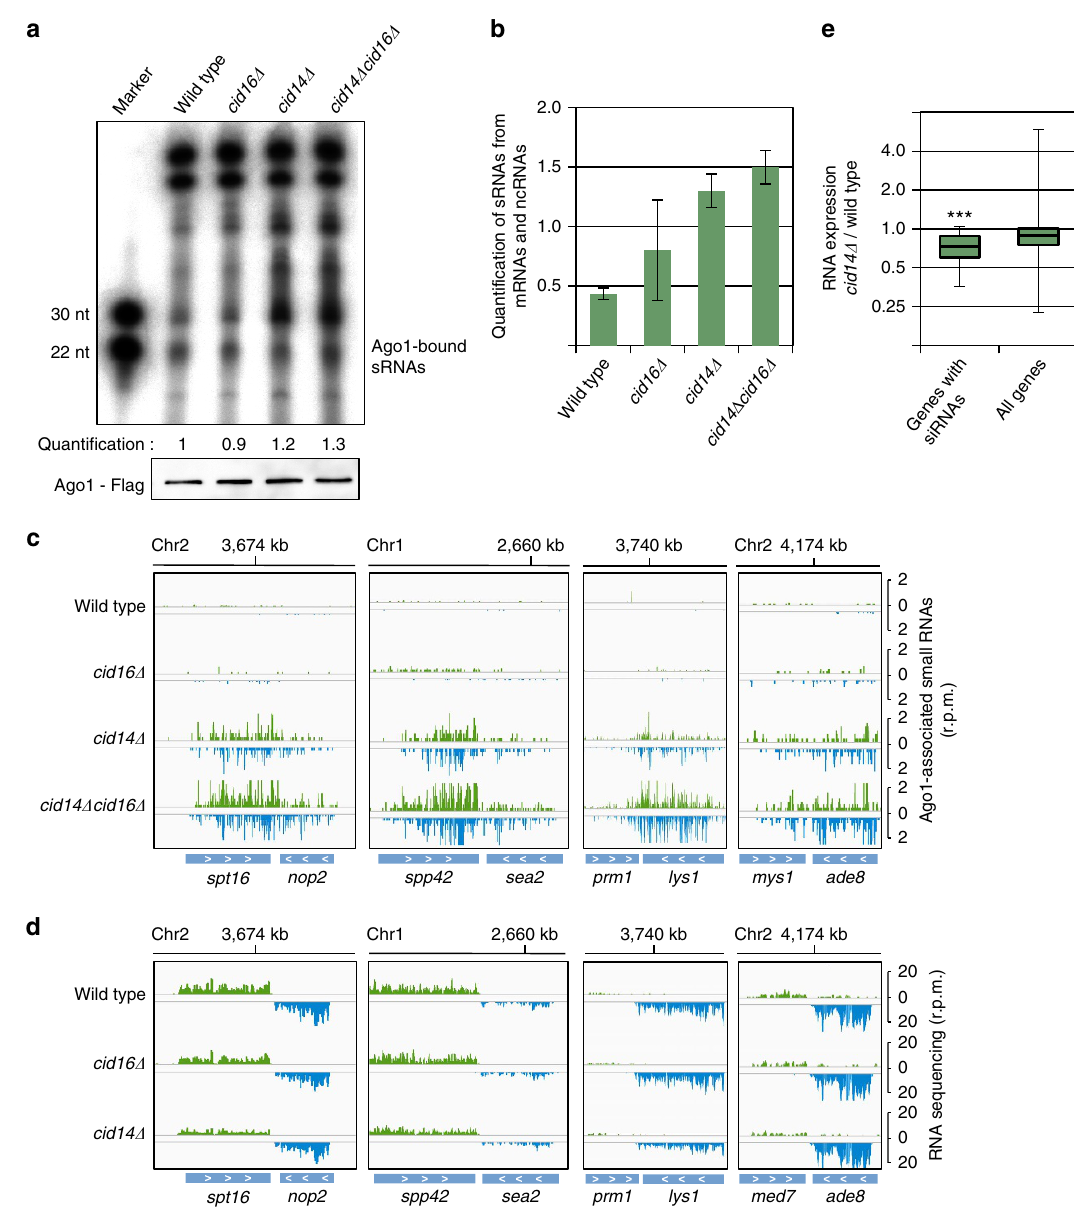
Figure 3 | Accumulation of antisense priRNAs triggers uncontrolled RNAi in cid14 D cells. ( a ) Autoradiograph of denaturing polyacrylamide gel showing Argonaute-bound RNAs purified from wild type, cid16 D , cid14 D and cid14cid16 D cells. Quantification is based on two independent biological replicates. Each band was normalized to higher unspecific bands of its lane and compared to wild type. Lower panels show western blotting detection of Flag-Argonaute protein in immunoprecipitation assays. ( b ) Quantification of euchromatic Argonaute-bound siRNAs and priRNAs mapping to mRNAs and ncRNAs in indicated strains. Euchromatic siRNAs and priRNAs accumulate in cid16 D , cid14 D and cid14cid16 D cells. Error bars indicate s.e.m. of two independent sRNA-sequencing experiments. ( c ) Argonaute-bound sRNA reads from indicated strains were plotted over euchromatic genes. The location of genes is indicated below the sRNA peaks. Reads from þ and (cid:2) strands are depicted in green and blue, respectively. Scale bars on the right denote sRNA reads numbers normalized per one million reads. In cid14 D and cid14 D cid16 D cells, RNAi targets euchromatic genes. ( d ) RNA-sequencing reads in indicated cells are plotted over the several euchromatic genes. In cid14 D cells genes that are targeted by RNAi are silenced. Scale bars on the right denote RNA reads numbers normalized per one million reads. ( e ) Box plot of differential expression of RNA in cid14 D cells compared to wild-type cells for all genes and genes that generate siRNAs in cid14 D cells. Genes that generate siRNAs show reduced level of mRNA in cid14 D cells indicating silencing by RNAi. Two sided t test for two independent datasets with high variance was used to calculate the P value. *** P o 1E (cid:2)